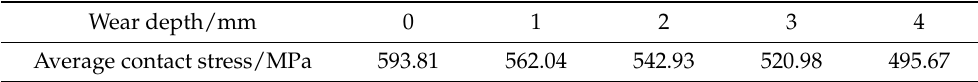
Table 4. Average contact stress of node A2 at elastic stage.